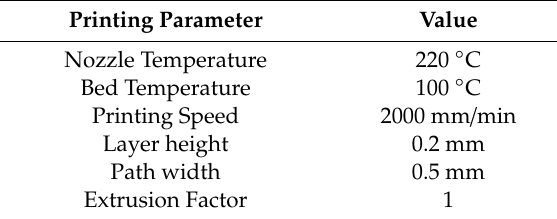
Table 5. Printing parameters maintained